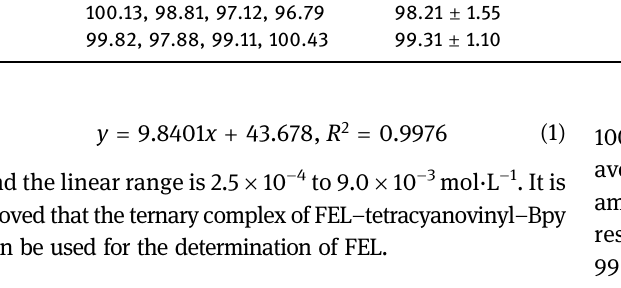
Table 4: Determination of FEL sample and comparison with labeled quantity Number Sample measurement ( mg ‧ L − 1